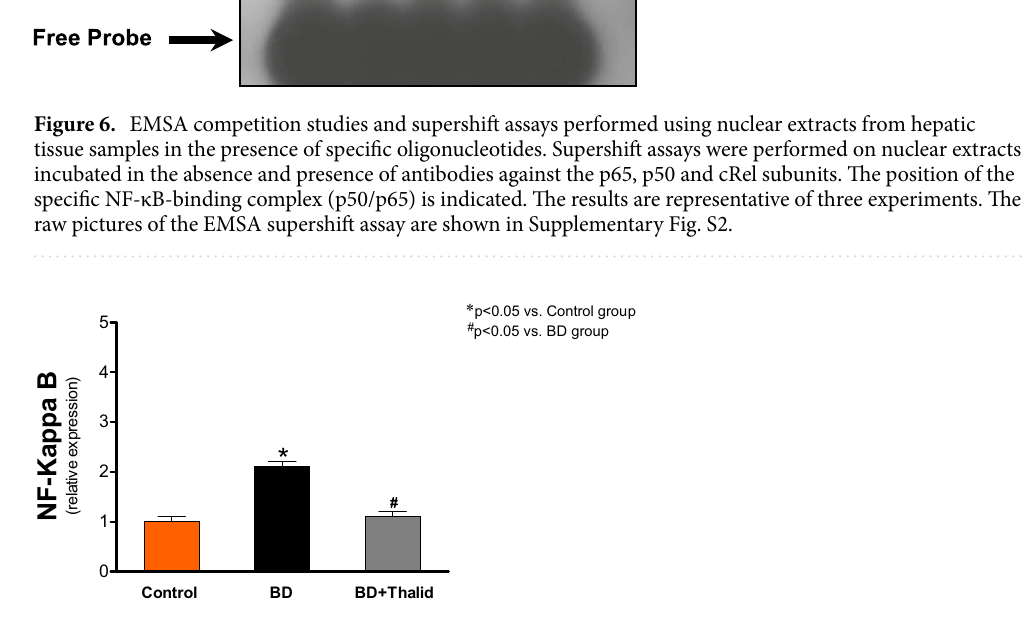
Figure 7. Comparative analysis of the expression of NF-κB as analysed by real-time RT–PCR in liver tissue 6 h after brain death induction in the different